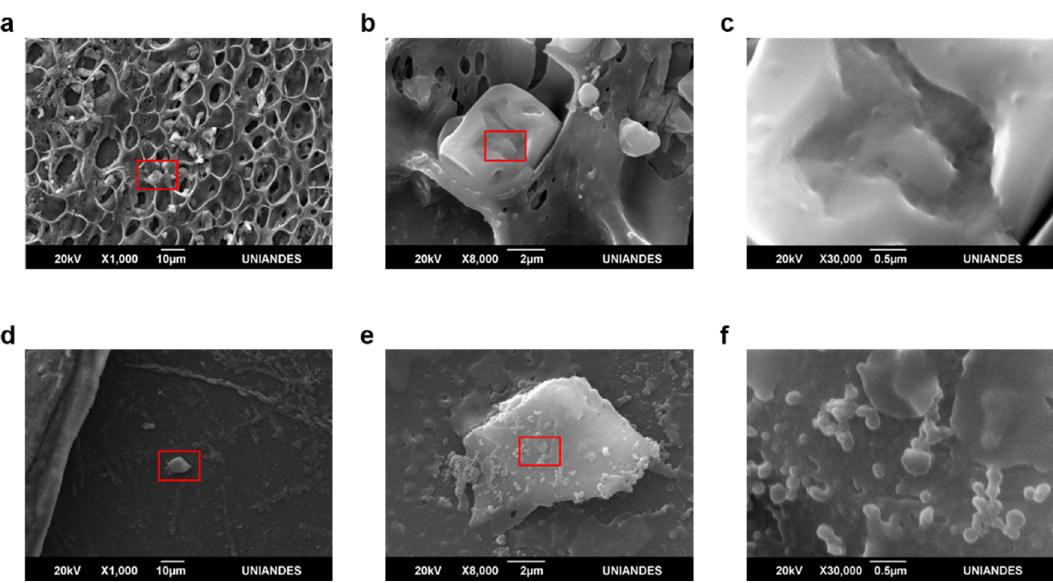
Figure 9. SEM images of PSS ‐ C prior to and after decolorization experiments. ( a ), ( b ), and ( c ) before decolorization of Congo Red. ( d ), ( e ), and ( f ) after decolorization of Congo Red. Surface morphology was quite smooth with an absence of observable irregular features. Additionally, it exhibits deposits, which were explained by the formation of crystals upon dye degradation.